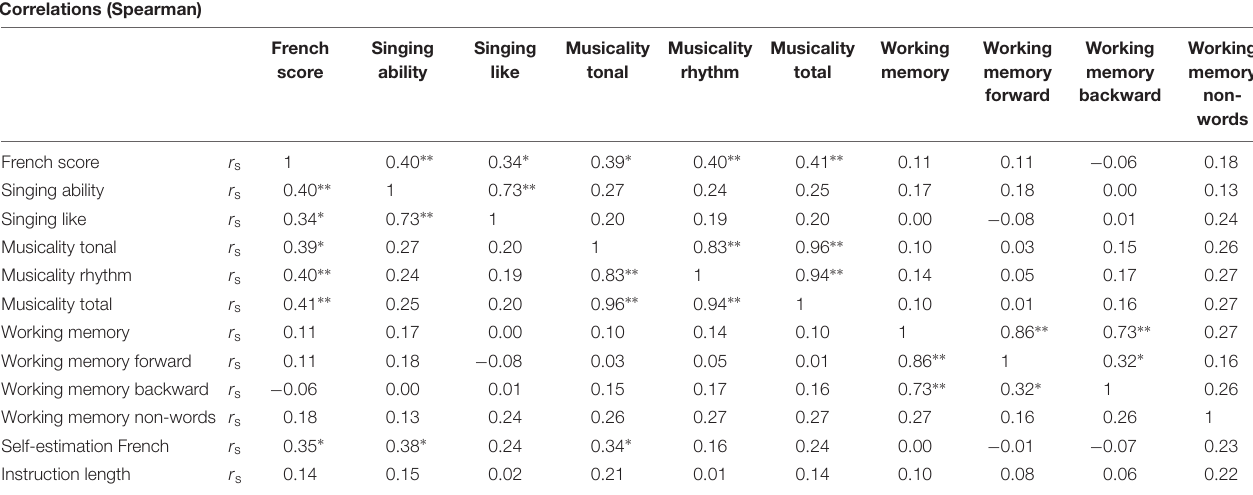
TABLE 2 | Results of the correlational